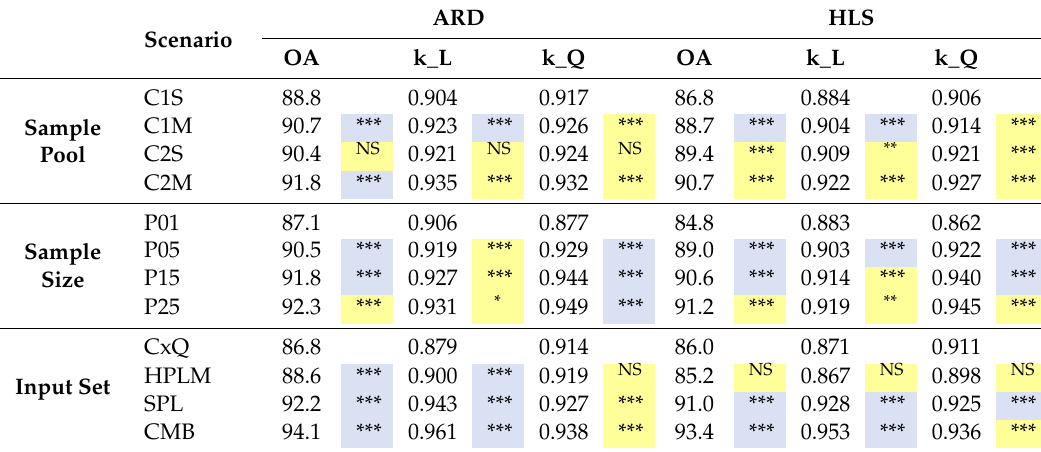
Table 5. Overall accuracy (in percent) and kappa indices for location and quantity of 2016 RFC models summarized by sample pools, sample sizes, and input variables. A particular scenario (current row) was compared to a scenario right above it (above row) using the nonparametric Mann–Whitney U test and the TOST equivalence test. The null hypothesis of the U test is that a random accuracy metric of the first scenario (above row) will be less than a random accuracy metric of the second scenario (current row). Significance levels of the U test are indicated by ***, **, and * for p-values of less than 0.001, 0.01, and 0.05, respectively. NS stands for “not significant”. Results of the TOST equivalence test are highlighted in light blue for “not equivalent” and light yellow for “equivalent”. Full pairwise comparisons are provided in Tables S3 and S4.